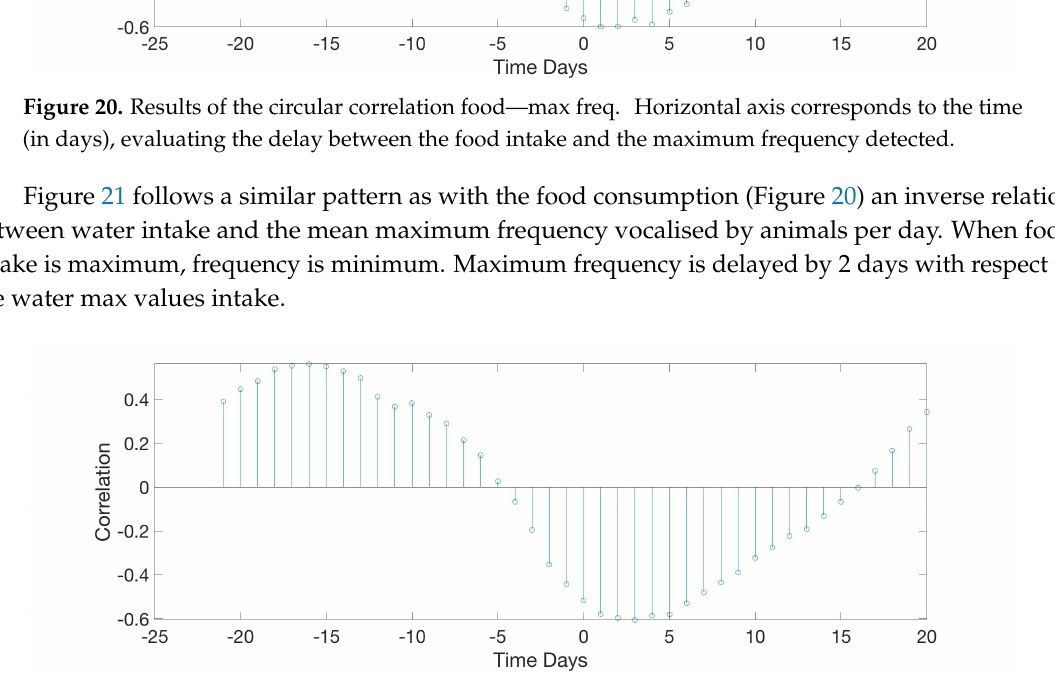
Figure 21. Results of the circular correlation water—max freq. Horizontal axis corresponds to the time (in days), evaluating the delay between the water intake and the maximum frequency detected.